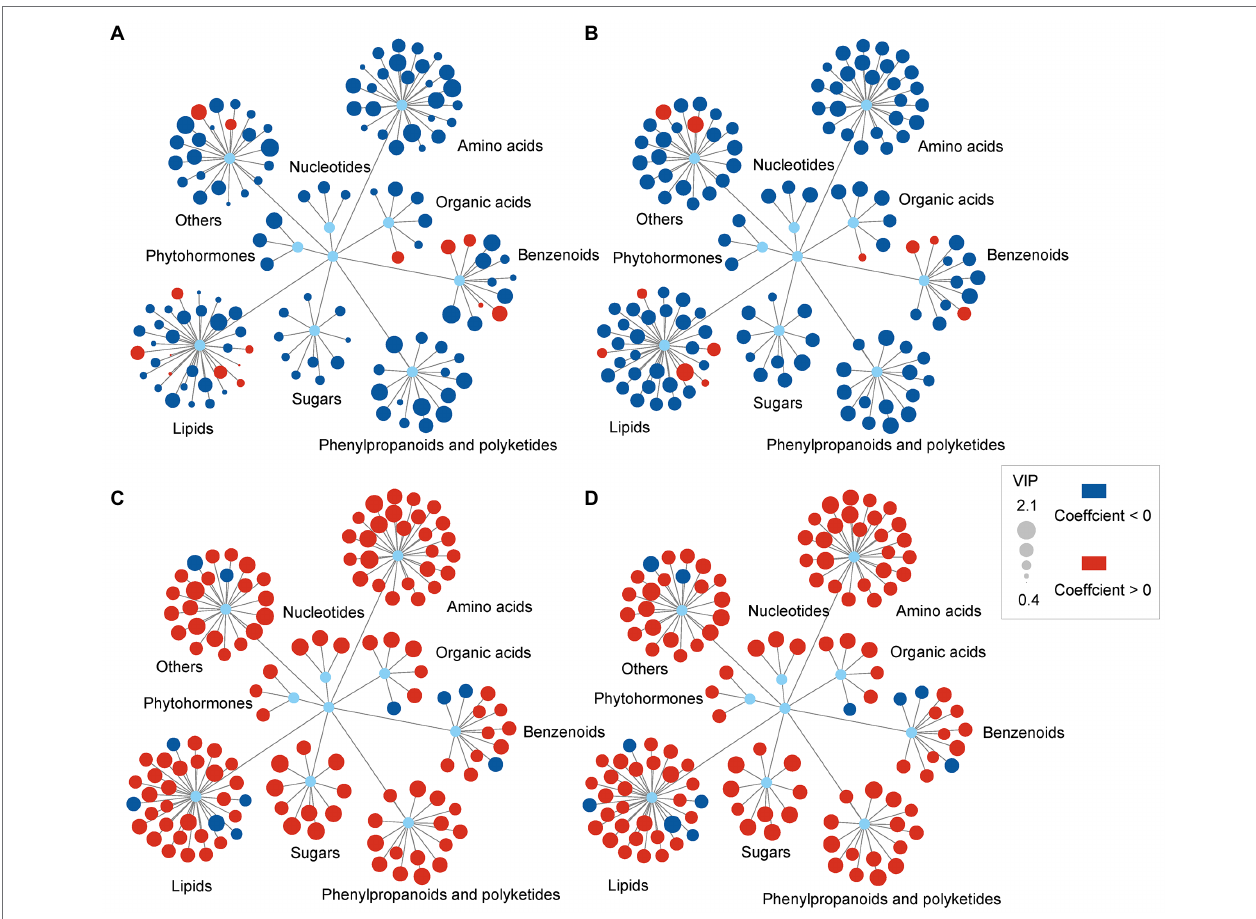
FIGURE 4 | Relationships between the differential metabolite changes and biological endpoints of C. breviculmis induced by drought stress. (A) Plant height as the biological endpoint. (B) Leaf fresh weight as the biological endpoint. (C) Soluble protein content as the biological endpoint. (D) MDA as the biological endpoint. The red and blue circles represent active and passive coefficients, respectively. The sizes of the circles represent the variable importance projection (VIP)